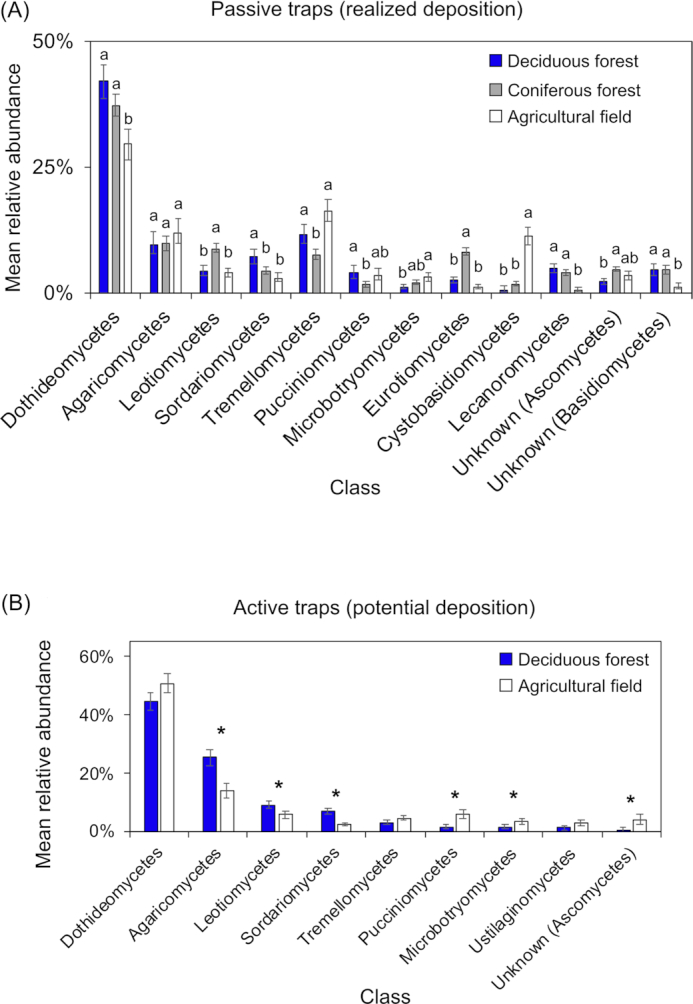
Comparison of relative abundances of fungal classes between vegetation types collected by (A) passive traps and (B) active traps. Bars indicate 95% confidence intervals. Different letters or asterisks indicate significant differences after applying the Bonferroni correction (corrected P-value = 0.0012).